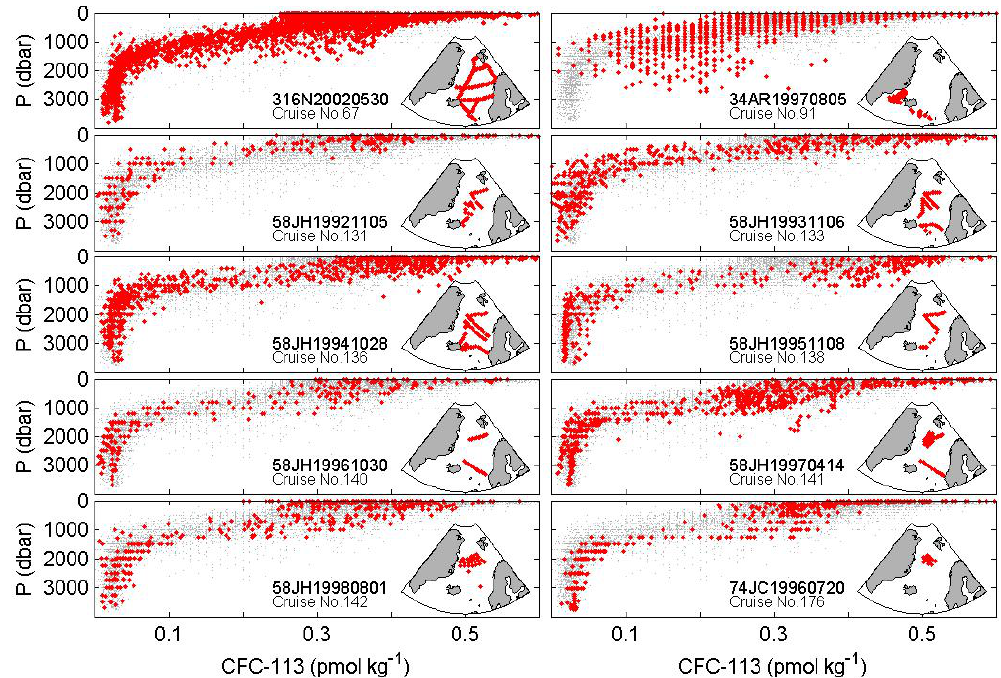
Figure 4. CFC-113 vs. pressure (dbar). See Fig. 2 for